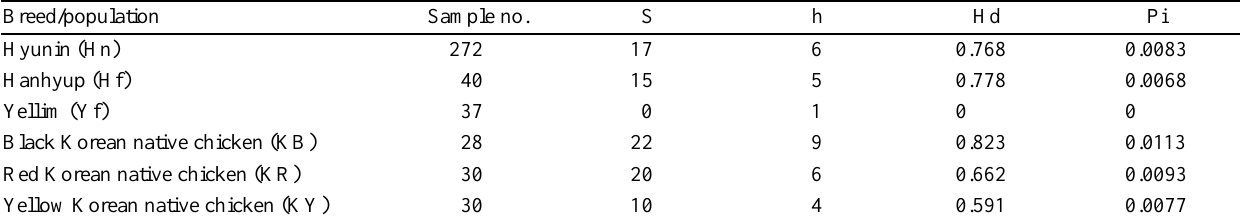
Table 1. The calculated number of variable sites (S), number of haplotype (h), haplotype diversity (Hd) and nucleotide diversity (Pi) using mitochondrial D-loop sequence polymorphisms for the Korean native chicken populations Breed/population Sample